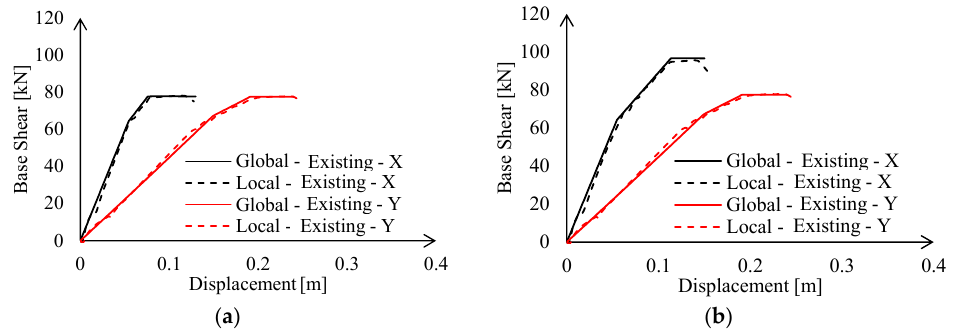
Figure 12. Calibration of the non-linear links of the existing MR connections under: ( a ) hogging and ( b ) sagging moment.